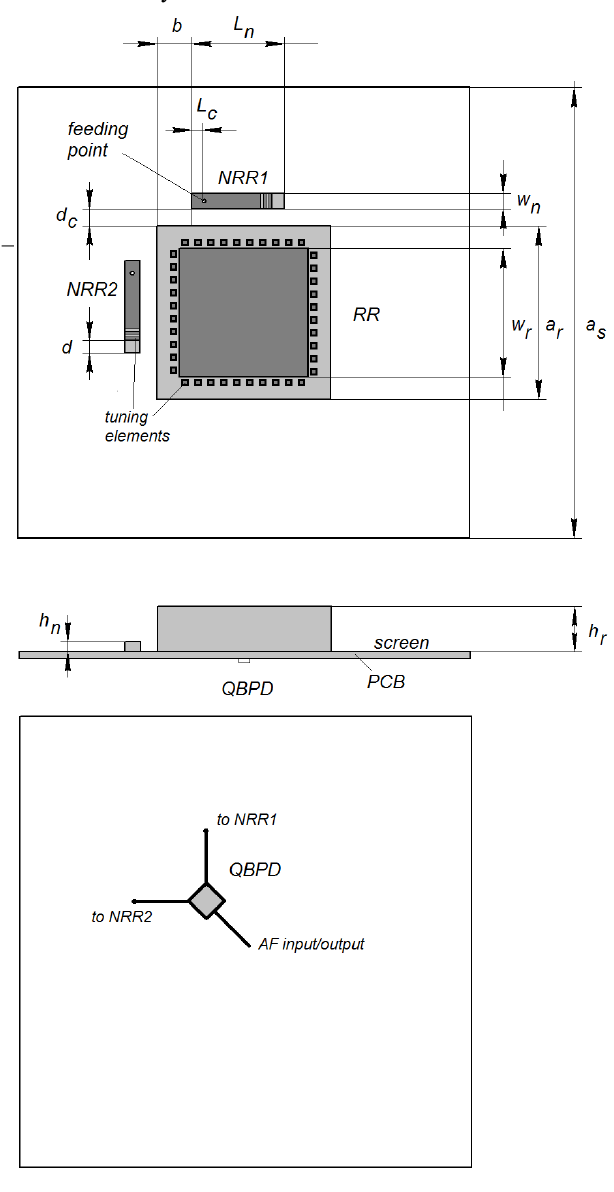
Fig. 1. Schematics of the circular polarization